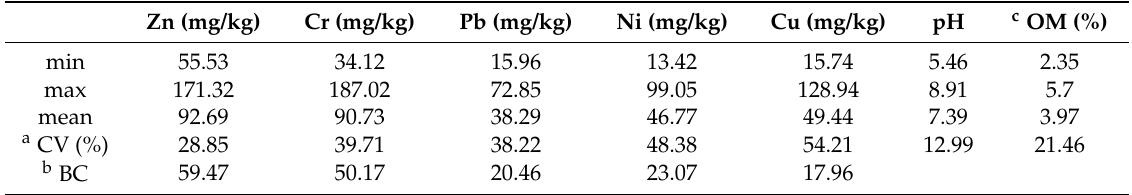
Table 2. Descriptive statistics of heavy metal concentrations in bed sediment of National Scenic Area Songhuahu (NSAS).